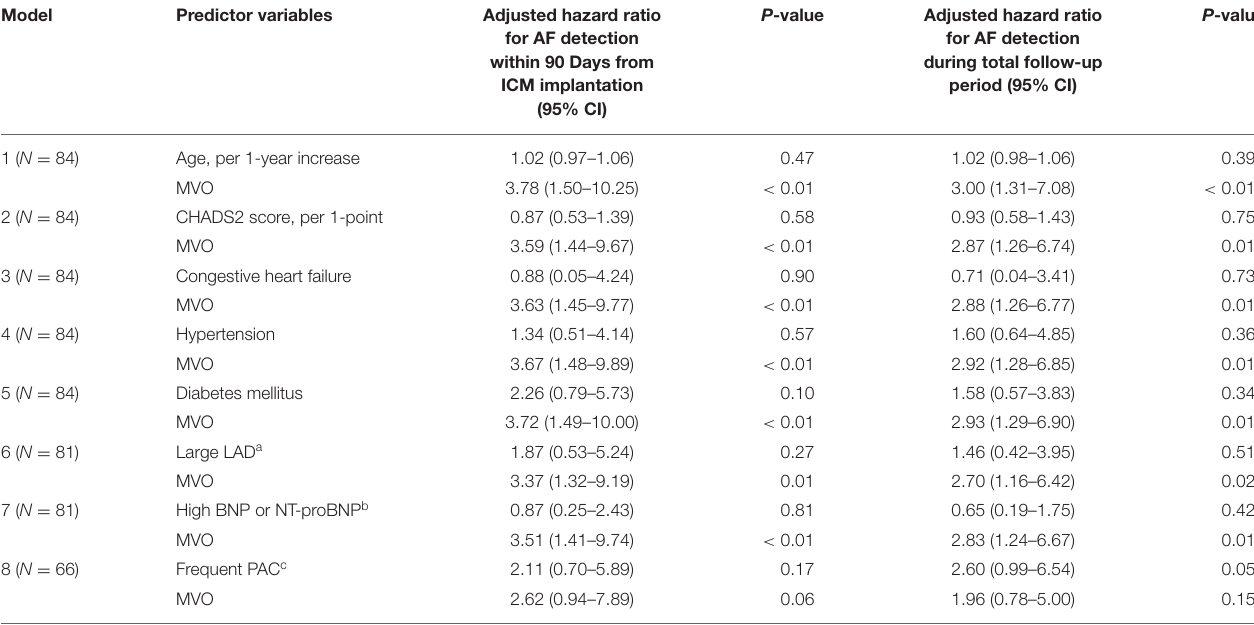
TABLE 3 | Hazard ratios for atrial fibrillation detection.